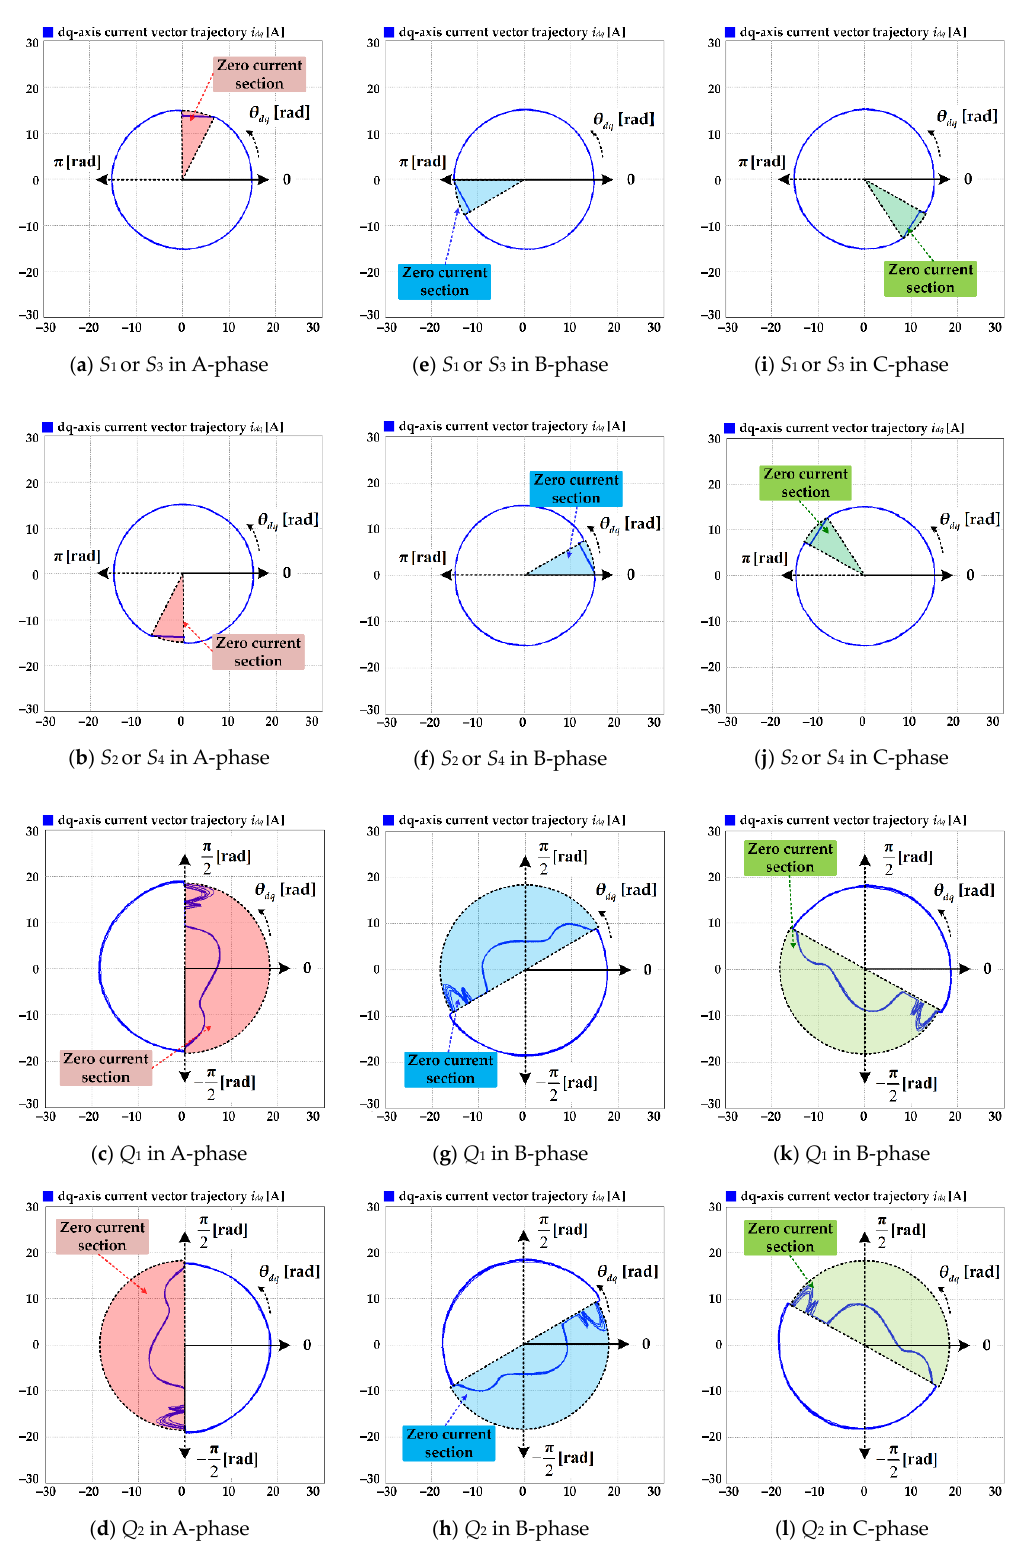
Figure 11. Current vector trajectories according to each faulty case (PF = 3 2 − ).